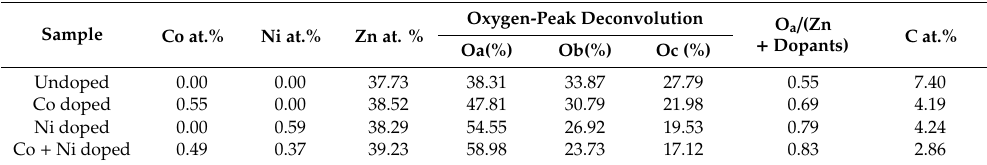
Table 2. Atomic percentages of Co, Ni, Zn, and C. Calculated ratios of each O-1s satellite peak and O a / (Zn + dopants) for the NR crystals estimated by XPS deconvolution analysis. (at. % = atomic percentage).